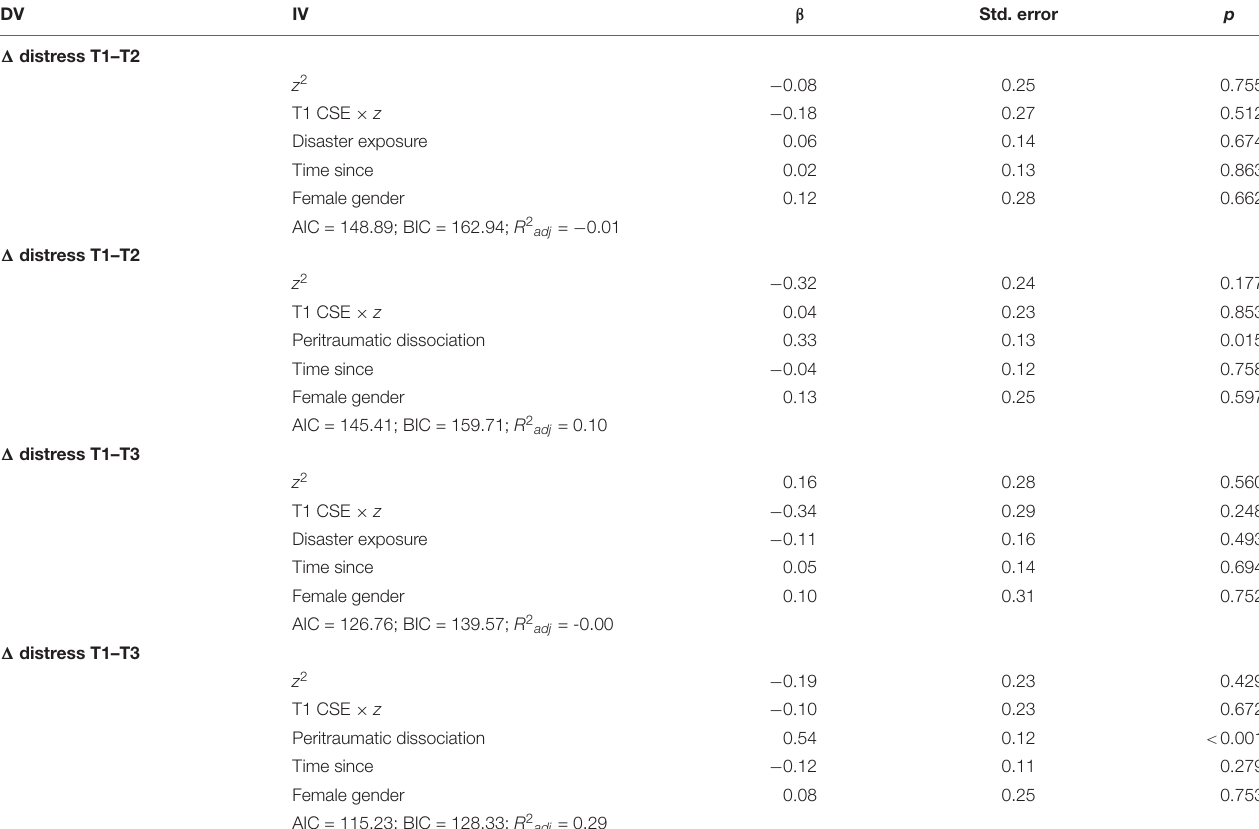
TABLE 7 | Standardized coefficients, standard error, and p -values for the cusp model in distress between time 1 and time 2 and in distress between time 1 and time 3 without participants suffering from the camp fire. DV IV β Std. error p